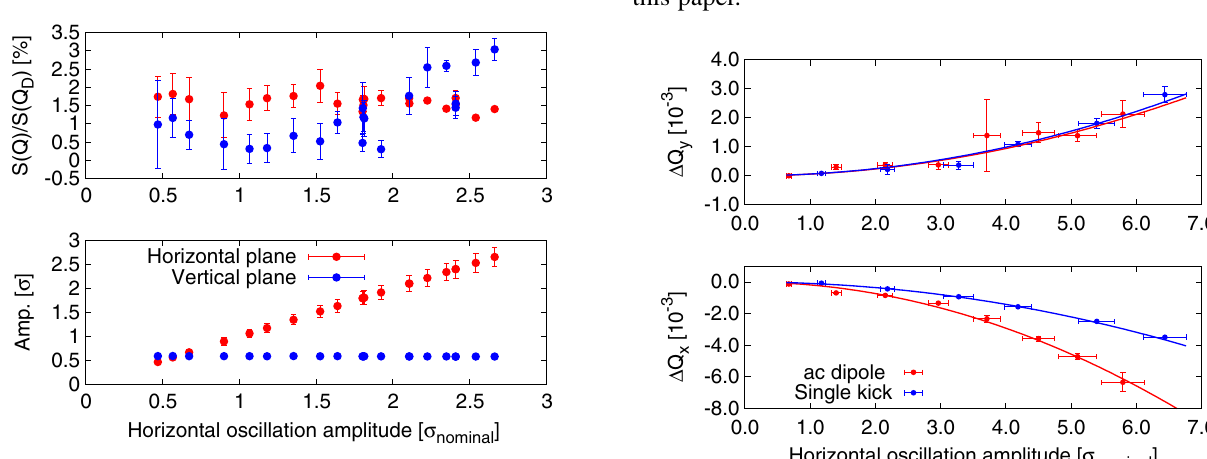
FIG. 8. Direct and cross term of the amplitude detuning at injection measured using a single kick or an ac dipole excitation for Beam 2. (cid:6) nominal represents the LHC nominal rms beam size for an emittance of 3 : 75 (cid:8) m . The plain lines represent a para- bolic fit of the data points.